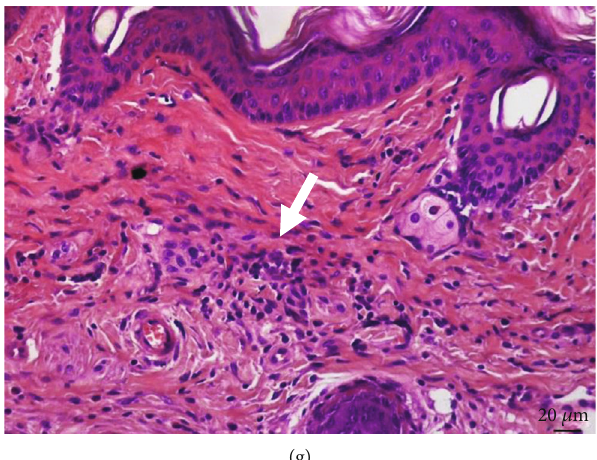
Figure 1: BALB/c mice were treated topically with butena fi ne chloride formulated in the self-nanoemulsifying drug delivery system (SNEDDS) or in a SNEDDS-based nanogel (SNEDDS gel) containing butena fi ne (10 mg of butena fi ne per dose), butena fi ne solubilized in DMSO (10 mg/dose), and blank formulations of the nanosystems or intralesionally treated with Glucantime (100mg/kg/dose) once a day during 15 days. Forty-eight hours after the last dose, fragments of the skin from BALB/c mice were collected and analyzed by histology. Histological section of the skin from (a) nontreated animals, (b) blank SNEDDS, (c) blank SNEDDS gel, (d) BUT-SNEDDS, (e) BUT- SNEDDS gel, (f) butena fi ne, and (g) Glucantime. White arrow shows an area of in fl ammatory in fi ltrate.